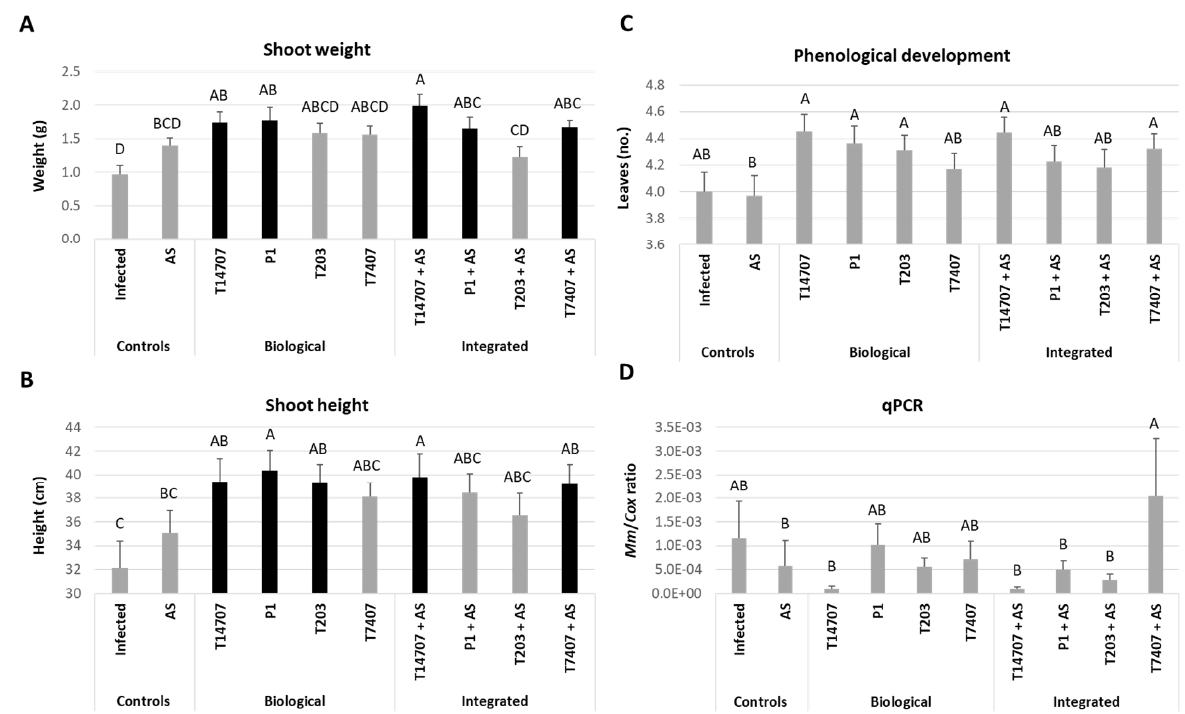
Figure 5. Growth room sprouts assay integrated control results. The Prelude maize cv. seeds were grown in M. maydis highly infected soil in 2-L pots for 20 days. While the control plants were left unprotected, chemical (0.25 mL/pot Azoxystrobin preparation (Amistar S.C.) with 0.0625 mg active ingredient), biological ( Trichoderma spp., Table 1), or integrated bio-chemo shield treatments were applied. The evaluation included the shoot fresh weight of the plants ( A ), the shoot height ( B ), phenological development (number of leaves, ( C )), and the relative amount of M. maydis DNA ( Mm ) normalized to the cytochrome C oxidase DNA (Cox) in the plants’ roots ( D ). The experiment was conducted in 9–10 repetitions per treatment (each repetition is a pot containing five sprouts). Error bars indicate standard error. Different letters (A– D ) above the chart’s bars represent an ANOVA test significant difference ( p < 0.05).